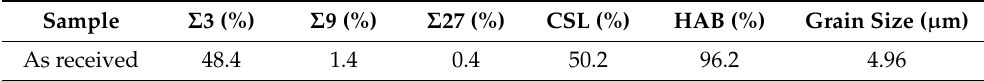
Figure 4. Microstructure of as-received 301 stainless steel: ( a ) SEM micrograph and ( b ) EBSD grain boundary construction map. HABs and LABs are shown in black and gray. Σ 3, Σ 9, and Σ 27 boundaries are denoted in red, yellow, and green, respectively. Table 3. Average grain size and grain boundary statistics for as-received